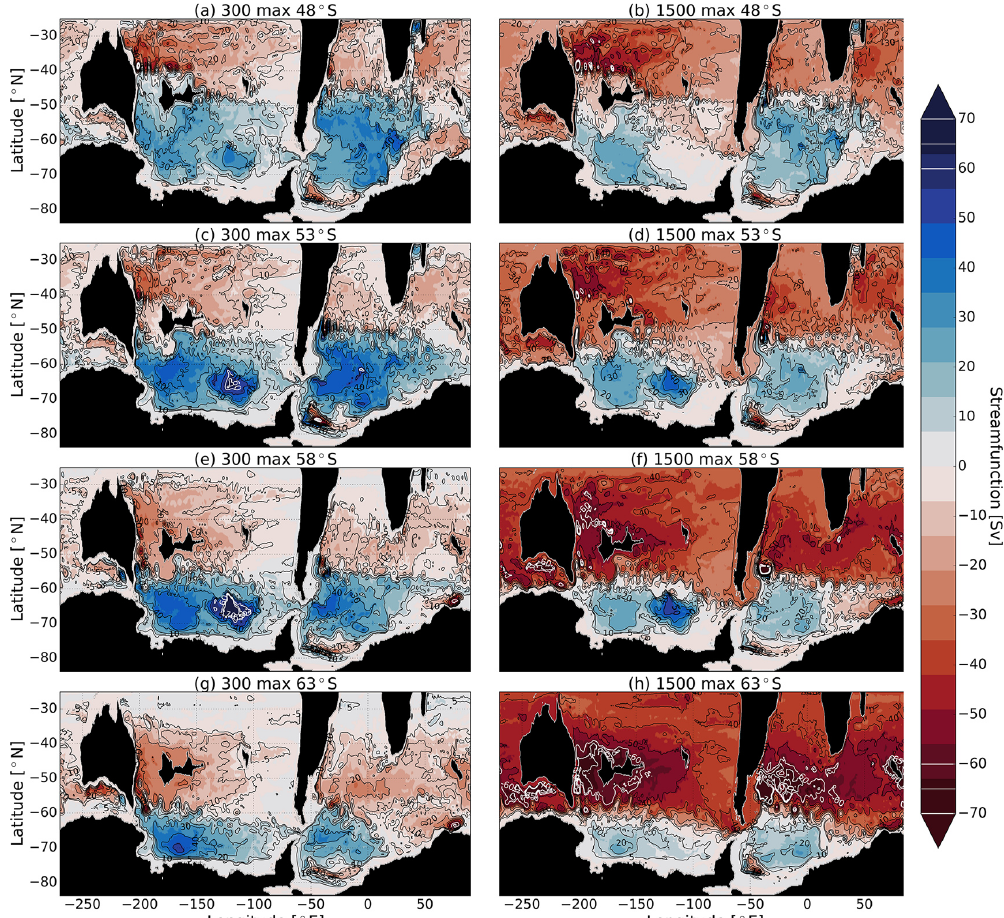
Figure 2. The 15-model-year time-average Southern Ocean circulation patterns (annual mean and depth-integrated stream function) under stepwise deepening of the Tasman Gateway from 300m (a, c, e, g) to 1500m (b, d, f, h) depth and wind stress meridional migrations (from top to bottom). Red colours indicate anti-clockwise subtropical gyres, and blue colours show clockwise subpolar gyres. The latitudes of τ m applied in four cases are 48 ◦ S (a, b) , 53 ◦ S (c, d) , 58 ◦ S (e, f) and 63 ◦ S (g, h) , respectively. White contours and contour labels at high positive or negative values ( − 70, − 65, − 60, 60, 65, 70Sv) are used to highlight strong